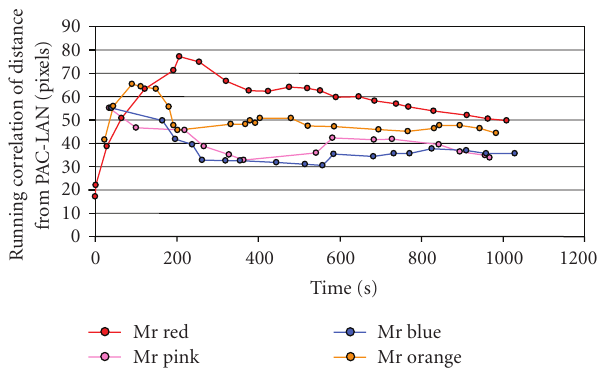
Figure 6: Running correlation of the Ghosts’ paths through the game relative to that of PAC-LAN.